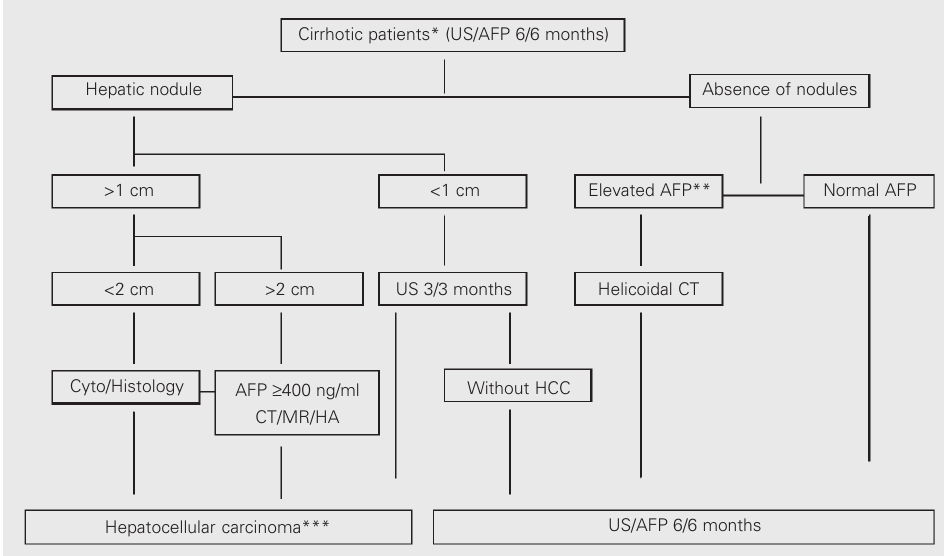
Figure 1. Diagnosis of